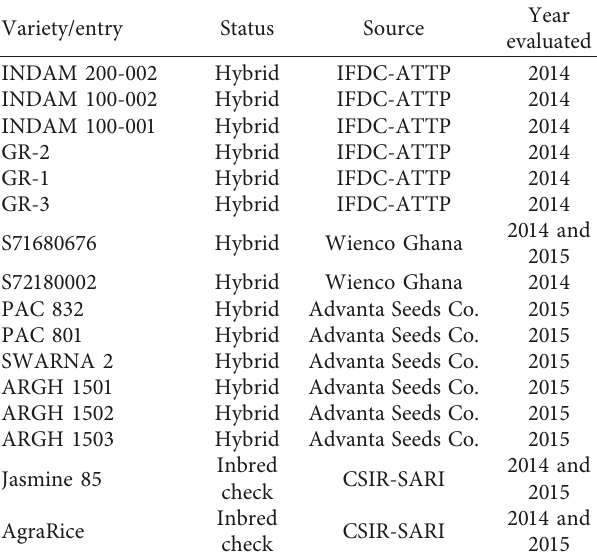
Table 1: List of hybrids and inbred checks used for the study. Table 2: Descriptive key for recording leaf blast disease